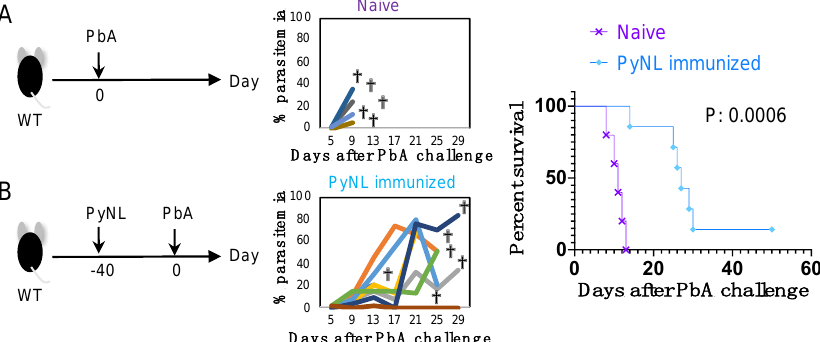
Figure 5. Limited cross-species protection against Plasmodium berghei ANKA (PbA) challenge following PyNL infection. Left panels show experiment protocol. Each group was challenged with blood-stage PbA on day 0. Center panels show parasitemia of each mouse. Each line indicates one mouse. Right panels show survival curves (N = 5–7). Two groups were compared. All data were pooled from two independent experiments. ( A ) Naïve mice (N = 5). ( B ) blood-stage PyNL immunized mice (N = 7). One mouse attained a maximum of 1.7% parasitemia at day 14 after PbA infection and cleared the parasite at day 20, while the remaining six animals succumbed to infection. Dagger indicates